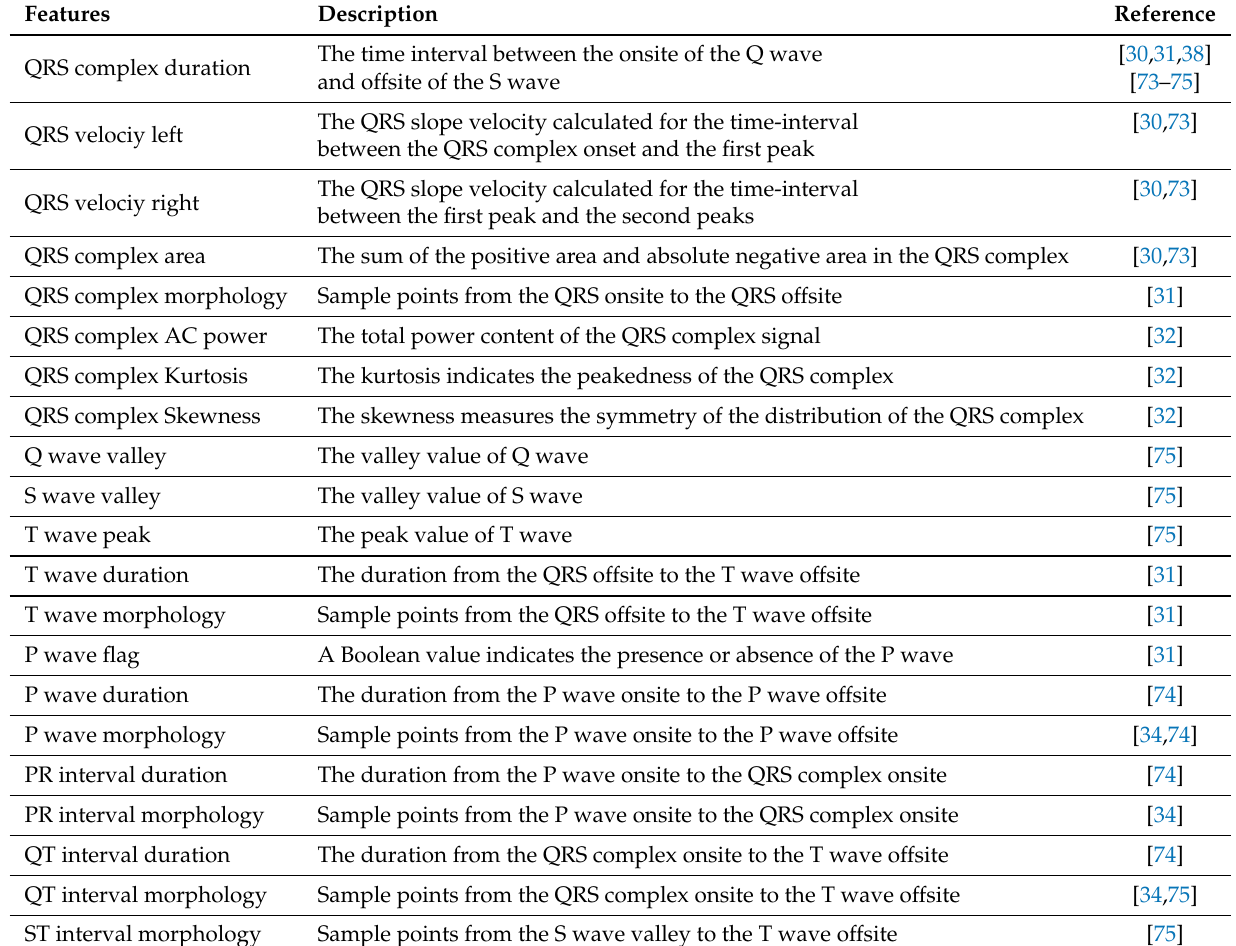
Table 2. Conventional Morphological Features of